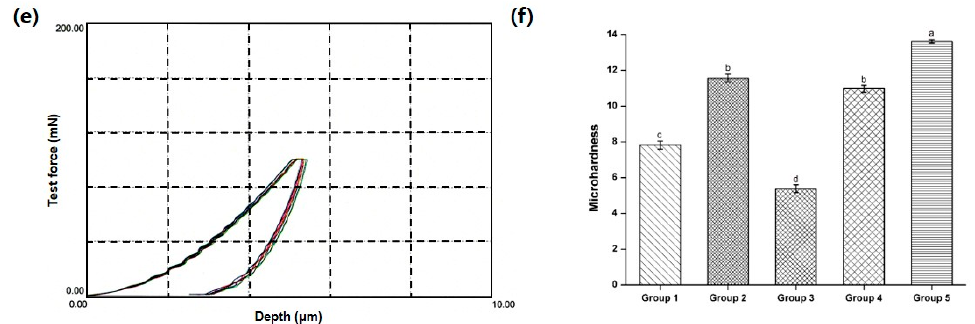
Figure 3. Microhardness of the five experimental groups. ( a – e ) Dynamic microhardness of Group 1–5, respectively; ( f ) Comparison of microhardness when maximum force is loaded. Group 3 had the lowest microhardness and Group 5 the highest ( p < 0.05). Groups 2 and 4 were not significant different ( p > 0.05, Tukey HSD test). Different colors in a–e means every test results.